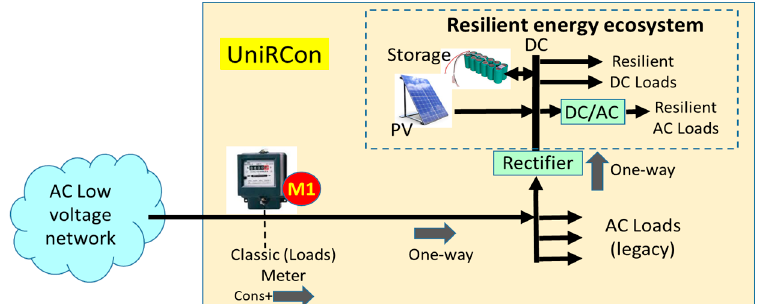
Figure 3. Renewables connected in an architecture allowing a resilient consumer behind the meter, labelled UniRCon (Uni-directional Resilient Consumer), with all-time load only behaviour on an AC low-voltage network.